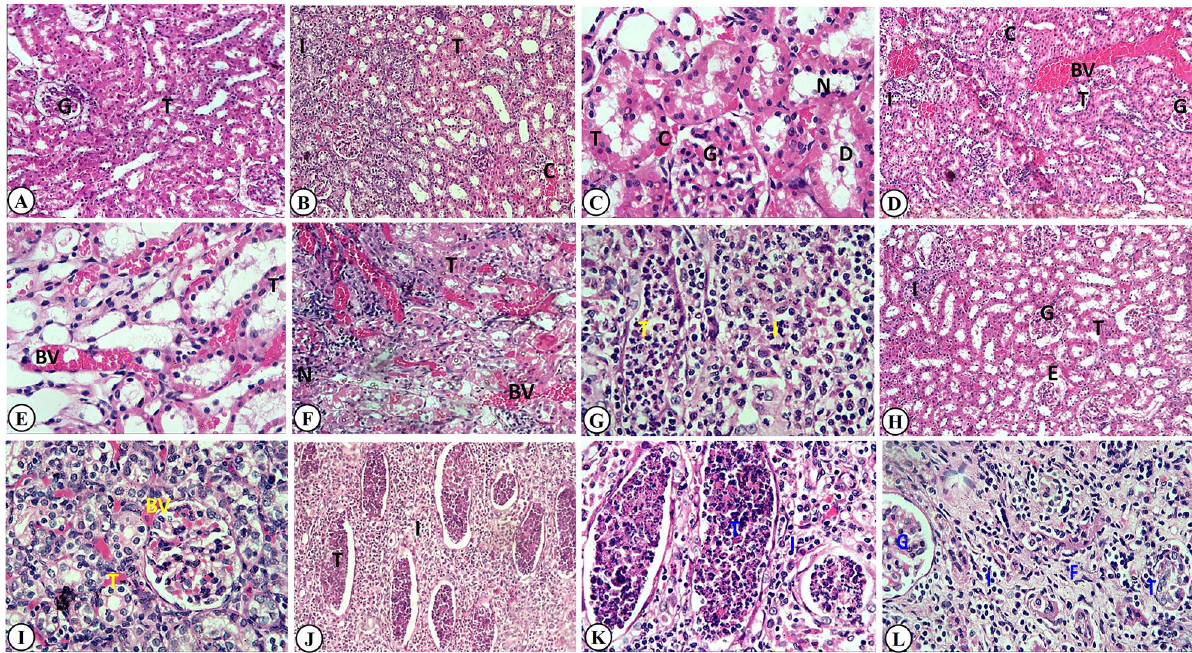
Figure 4. Representative histopathological photomicrographs of hematoxylin-stained cross-sections of rat kidneys. ( A ) Control group: showing normal structure with renal glomeruli (G) and tubules (T) (H&E stain, × 100). Butylated hydroxyanisole-treated group showing: ( B ) degenerative changes in renal tubular cells (T), focal leucocytic infiltrations (I), and congestion of intertubular blood vessels (C) (H&E stain × 100). ( C ) Granular degeneration in renal tubular cells (T), the desquamated epithelium (D), cellular swelling with pyknotic nuclei (N), congestion of intertubular blood vessels (C) with vasculitis (V) (H&E stain, × 400). Potassium sorbate-treated group showing: ( D ) degeneration of renal tubules (T), intertubular blood vessels (BV) and glomerular tuft (C) congestion, focal interstitial nephritis(I), glomerular shrinkage (G) (H&E stain, × 100). ( E ) Tubular granular degeneration (T) and congestion of intertubular blood vessels (BV) (H&E stain, × 400). Sodium benzoate-treated group showing: ( F ) chronic interstitial glomerulonephritis (N) with cloudy swelling of tubules (T) and congestion of intertubular blood vessels (BV) (H&E stain × 100). ( G ) chronic interstitial nephritis with vacuolated cytoplasm and pyknotic nuclei, degenerate and desquamated epithelial cells, and leucocytic infiltrations mainly neutrophils within tubules (T) as well as interstitial inflammatory cell infiltrates (I) (H&E stain, × 400). Boric acid-treated group showing: ( H ) tubular cell swelling (T), congestion of intertubular blood vessels and glomerular tuft (G), interstitial leucocytic infiltrations (I) and glomerular edema (E), and shrinkage (H&E stain, × 100). ( I ) Vacuolar degeneration in renal tubular cells (T), desquamation of lining epithelium, narrowing of tubular lumen, and congestion of intertubular blood vessels (BV) (H&E stain, × 400). Calcium propionate-treated group showing: ( J ) chronic interstitial glomerulonephritis with dilated tubules and filled with degenerated cells, leucocytic infiltrations, and desquamated epithelial cells (T), interstitial inflammatory cell infiltrates (I) (H&E stain, × 100). ( K ) Degenerated cells, leucocytic infiltrations, desquamated epithelial cells within dilated tubules (T), interstitial inflammatory cell infiltrates (I), and tubular atrophy (H&E stain, × 400). ( L ) Chronic interstitial glomerulonephritis with atrophy of tubules (T), interstitial fibrosis (F), and inflammatory cell infiltrates (I) as well as glomerular edema, hyperemia, and shrinkage (G) (H&E stain, ×